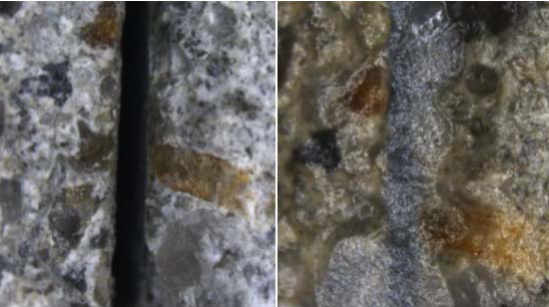
Figure 2. Micrographs of a self ‐ healing (containing bacterial ACDC granules) mortar specimen with 300 µm wide crack before (left) and after (right) 28 d submersion in a 0.4 M chloride solution, showing complete crack healing (courtesy of Yusuf Ça ğ atay Er ş